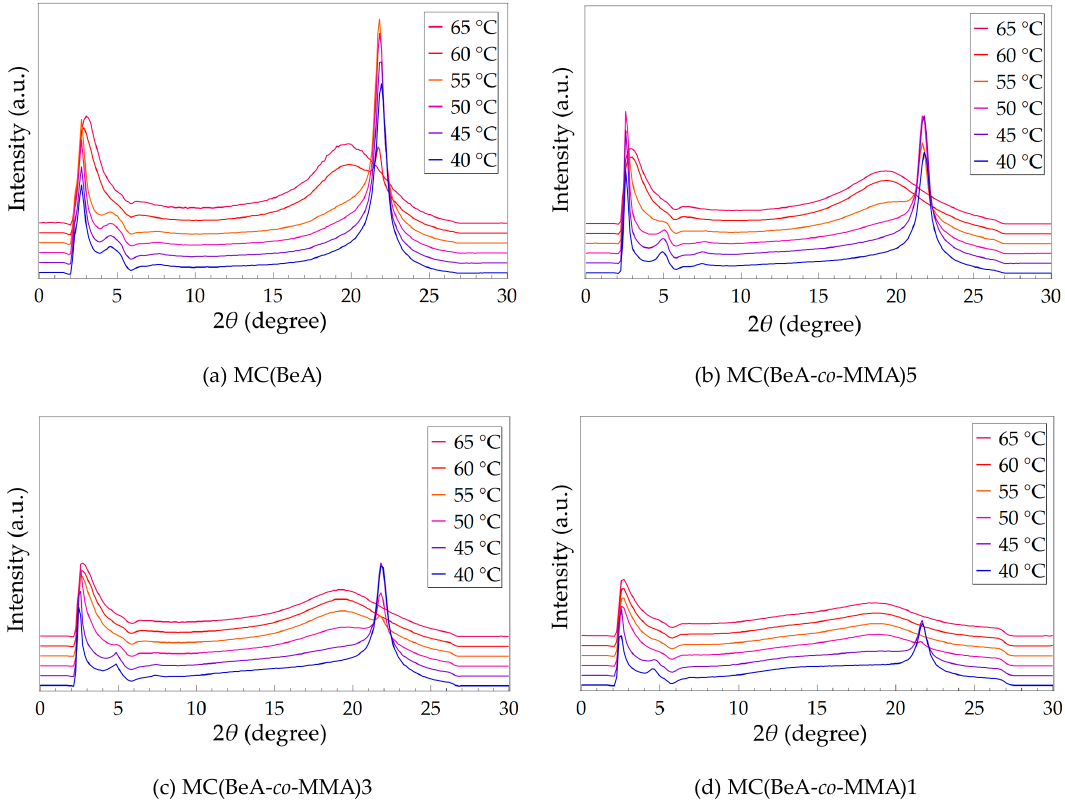
Figure 4. SAXS patterns of MC(BeA- co -MMA) microcapsules and MC(BeA) in the cooling process from the isotropic phase to the crystal phase at a cooling rate of 0.5 °C·min − 1 . The scale of intensity for each diagram is the same, aiming to give a clear understanding and direct comparison.